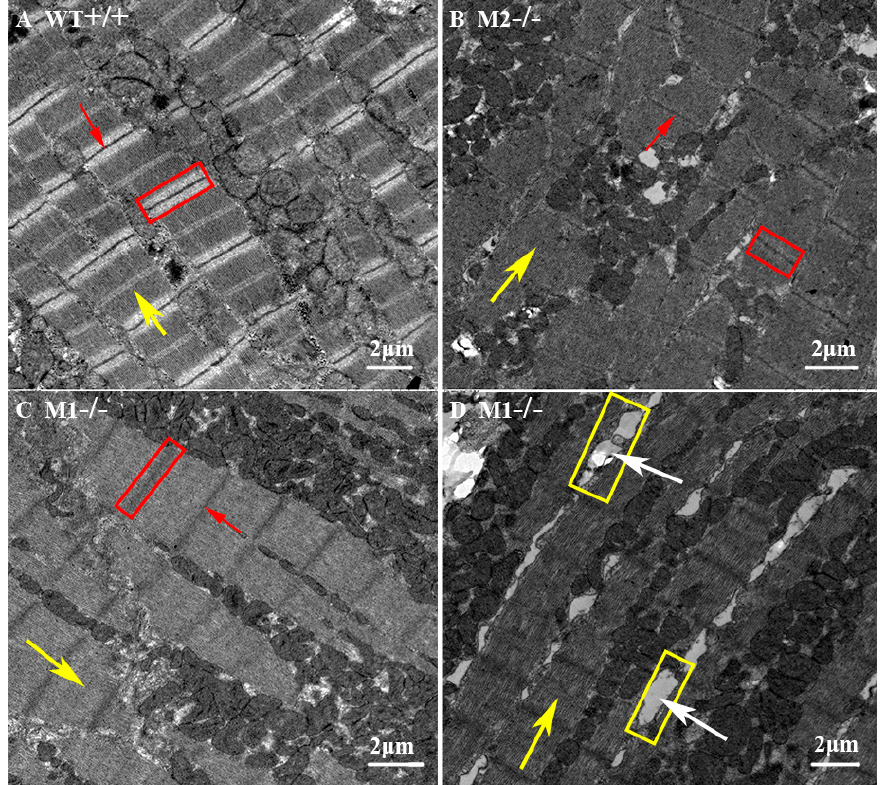
Figure 6. Ultrastructure of adult heart tissues observed using transmission electron microscopy. Pr130 -/- zebrafish displayed disordered myocardium. In pr130 -/- heart, the boundary of bright band ( red boxes ), M line ( yellow arrows ), and Z line ( red arrows ) were not clear. In some cases the gaps between some longitudinal myocardial fibers increased ( yellow boxes and white arrows ).